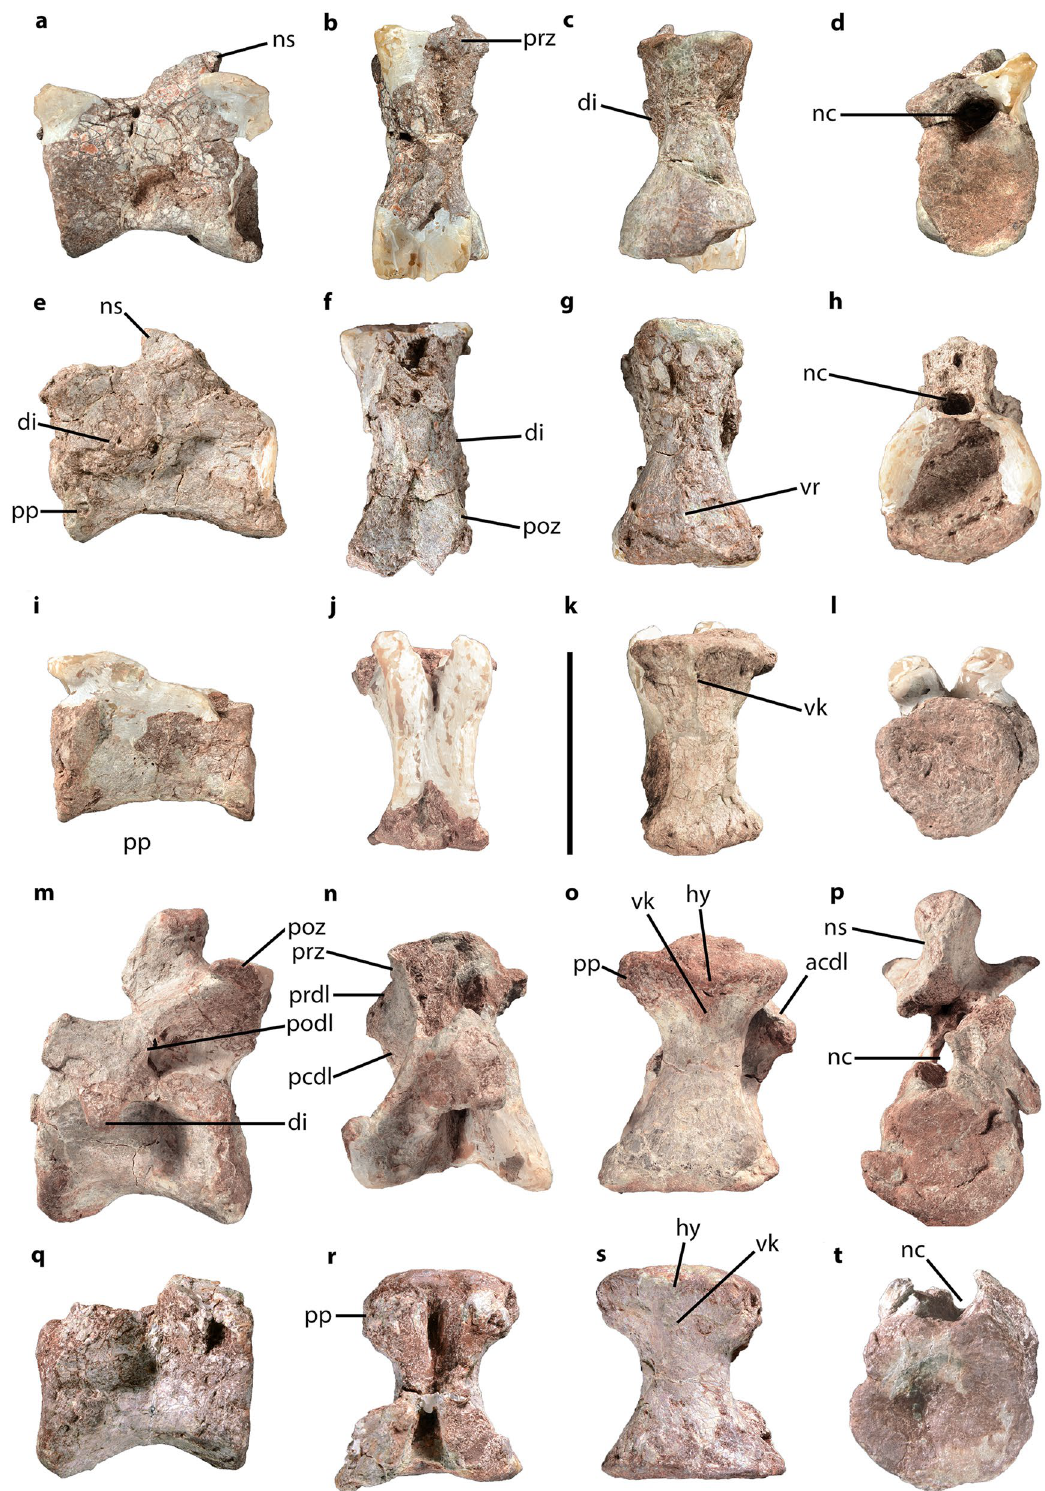
Figure 6. Irisosaurus yimenensis cervical vertebrae in, from left to right, left lateral, dorsal, ventral and anterior views. ( a–d ) Anterior cervical (C3-C5?); ( e–h ) Middle cervical (C5-C7?); ( i–l ) Middle cervical (C6-C8?) centrum; ( m–p ) Posterior cervical (C9?); ( q–t ) Posterior cervical (C10?) centrum. Abbreviations: acdl, anterior centrodiapophyseal lamina; di, diapophysis; hy, hypapophysis; nc, neural canal; ns, neural spine; pcdl, posterior centrodiapophyseal lamina; podl, postzygodiapophyseal lamina; poz, postzygapophysis; pp, parapophysis; prdl, prezygodiapophyseal lamina; prz, prezygapophysis; vk, ventral keel; vr, ventral ridge. Scale bar = 10